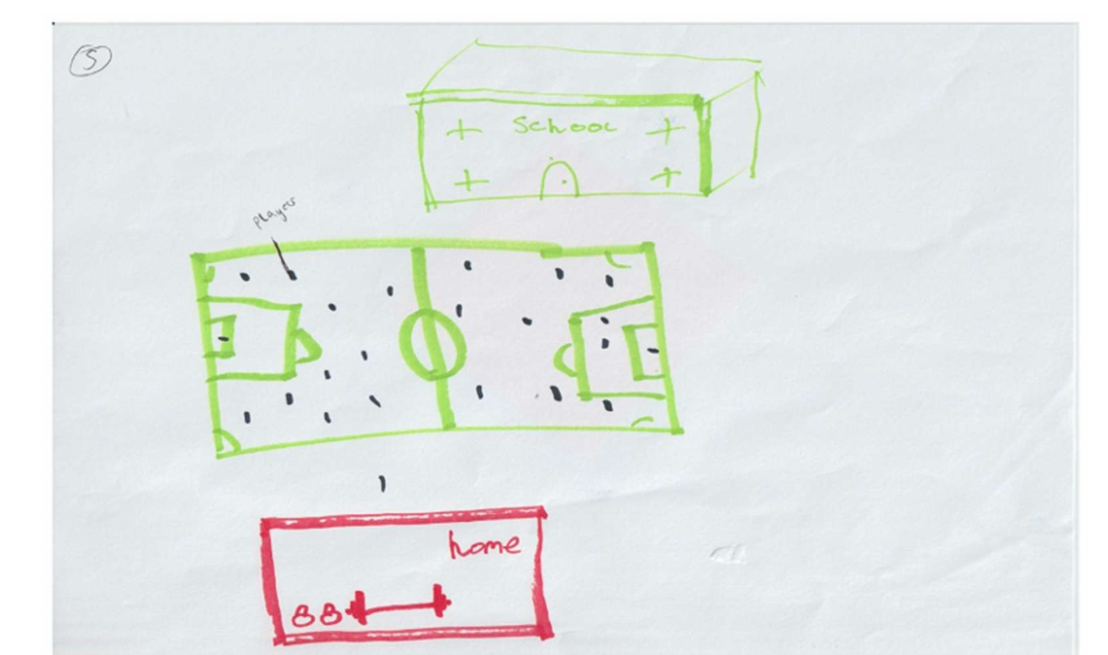
Figure 7. Drawing illustrating the perceived difference in activities conducted at school and out of school. (ID27). “School is mostly football and that. When I go home I can do weights, it’s just not something we do here